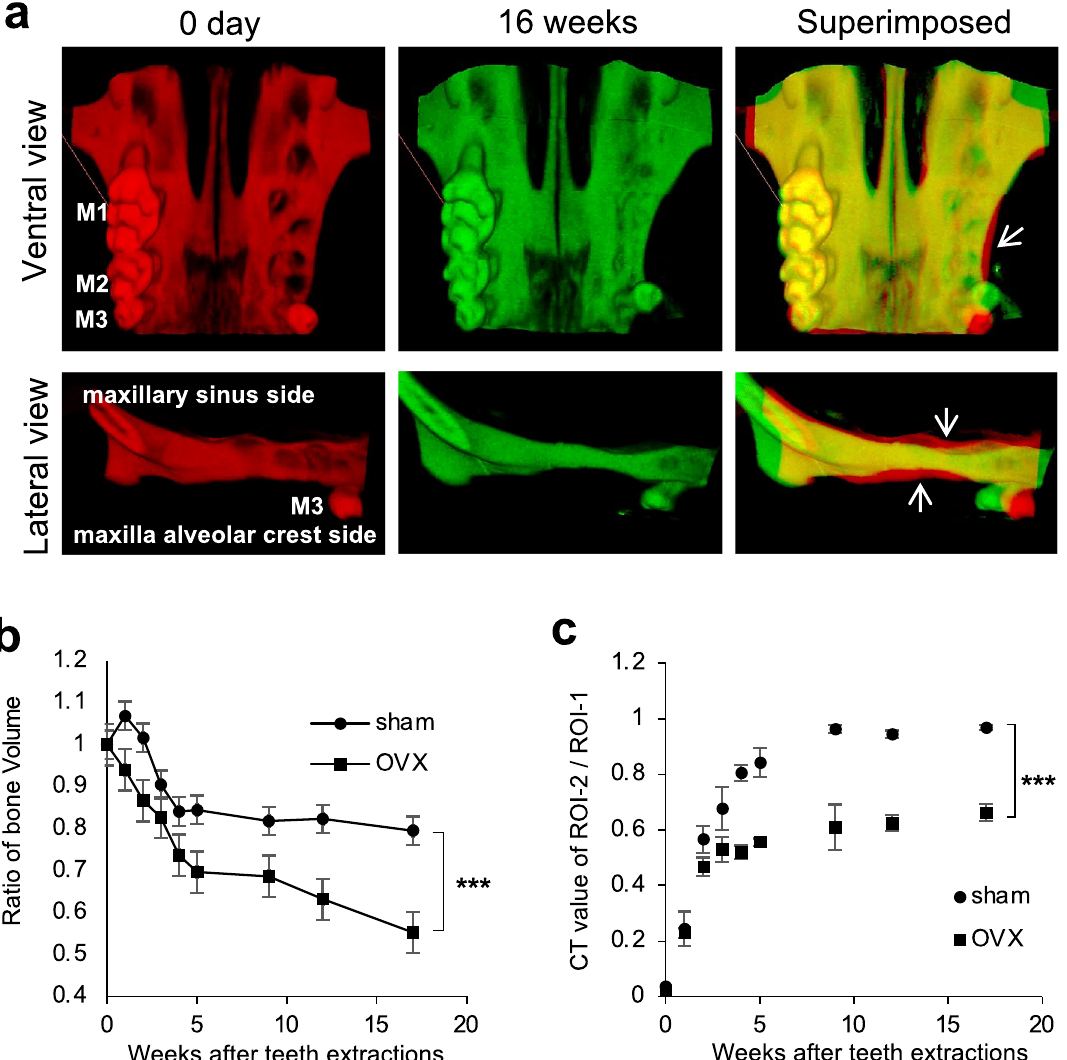
Figure 2. Ovariectomy prolongs maxillary bone resorption after teeth extractions. ( a ) Ventral views (upper images) and lateral views (lower images) of μCT-3D images of the maxilla at day 0 (red) and 16 weeks (green) post-extraction of OVX mice are shown in the left and the middle images, respectively. The right image shows a superimposed illustration of day 0 and 16 weeks post-extraction. The arrows indicate decreased regions of the alveolar bone after 16 weeks post-extraction. ( b ) The graph shows the time-dependent changes in the bone volumes of the teeth-extracted side of the alveolar bone as described in Fig. 1a. Closed squares represent OVX mice and closed circles represent sham mice as the control. Data are expressed as mean ± S.D. (n = 3). ( c ) The graph shows the time-dependent changes in the ratio of the CT values of the maxilla alveolar bone of the extracted region (ROI-2) to the non-extracted buccal side (ROI-1) of the alveolar bone of OVX mice (closed square) and sham mice (closed circle), as described in Fig. 1b. The data shown in the graphs are representative of two independent experiments. *** P < 0.005; calculated using two-way